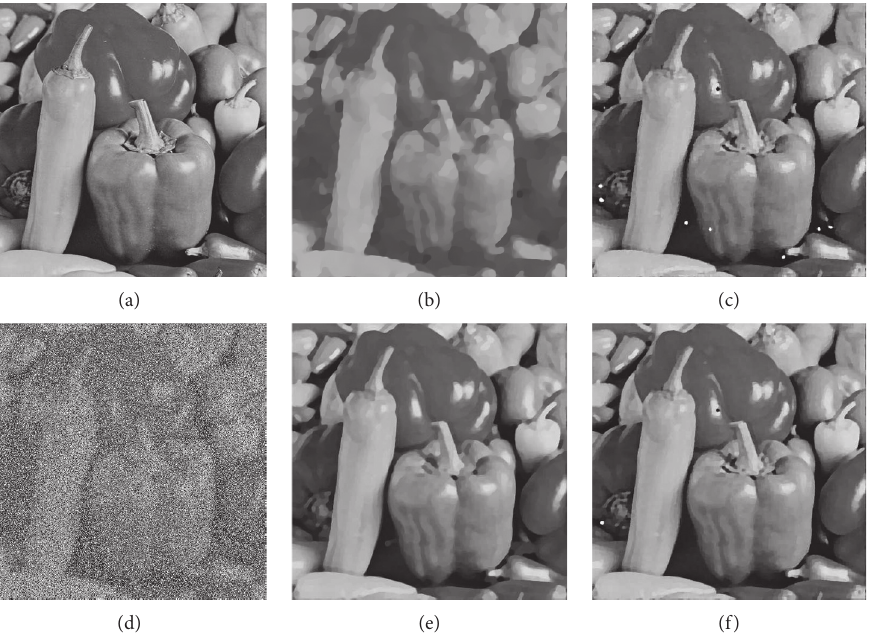
Figure 14: The recovery results (Peppers 512) by Gaussian blur with 70% RV noise. (a) Original. (b) TVL1, PSNR � 19.1797. (c) TVSCAD, PSNR � 26.0516. (d) Gaussian blur (lev � 0.7). (e) TVLog, PSNR � 26.4081. (f) LogTVSCAD, PSNR � 27.9344.